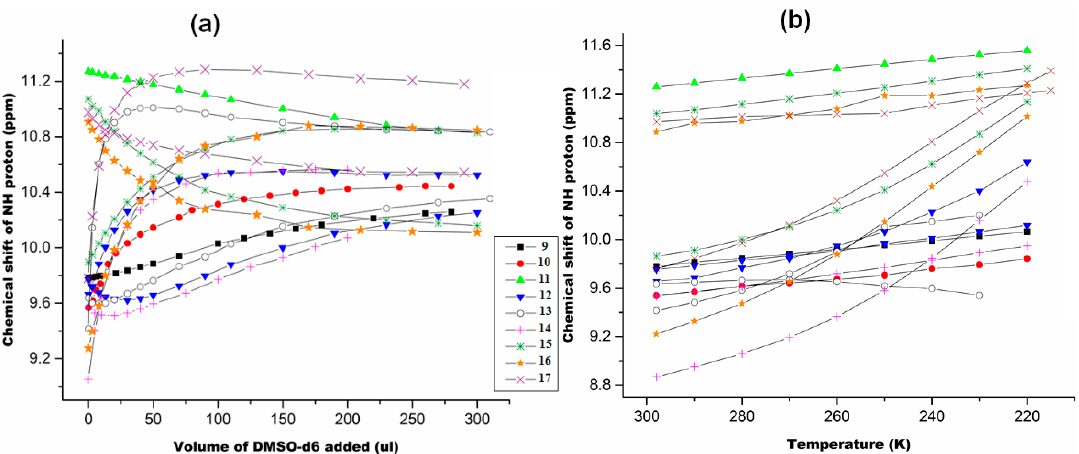
Figure 15. ( a , b ) Variation in the chemical shifts of NH proton as a function of temperature and the volume of DMSO- d 6 respectively for the molecules 9 – 17 . The initial concentration was 10 mM in the solvent CDCl 3 . ( a ) The DMSO- d 6 was incrementally added to an initial volume of 450 µL in CDCl 3 , at 298 K; ( b ) The temperature was varied from 300 to 220 K. The molecules 9 – 17 are identified by the symbols given in the inset.